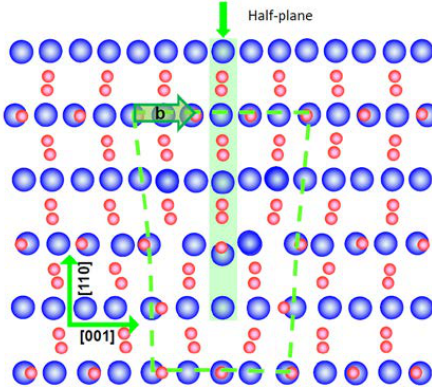
Figure 1. Relaxed atomic model of an edge dislocation in TiO 2 with Burgers vector b = ¼ [001] viewed from the [110] projection. The model is constructed based on experimental images. The larger balls are Ti atoms and the smaller ones are O atoms (Adapted from [32]).